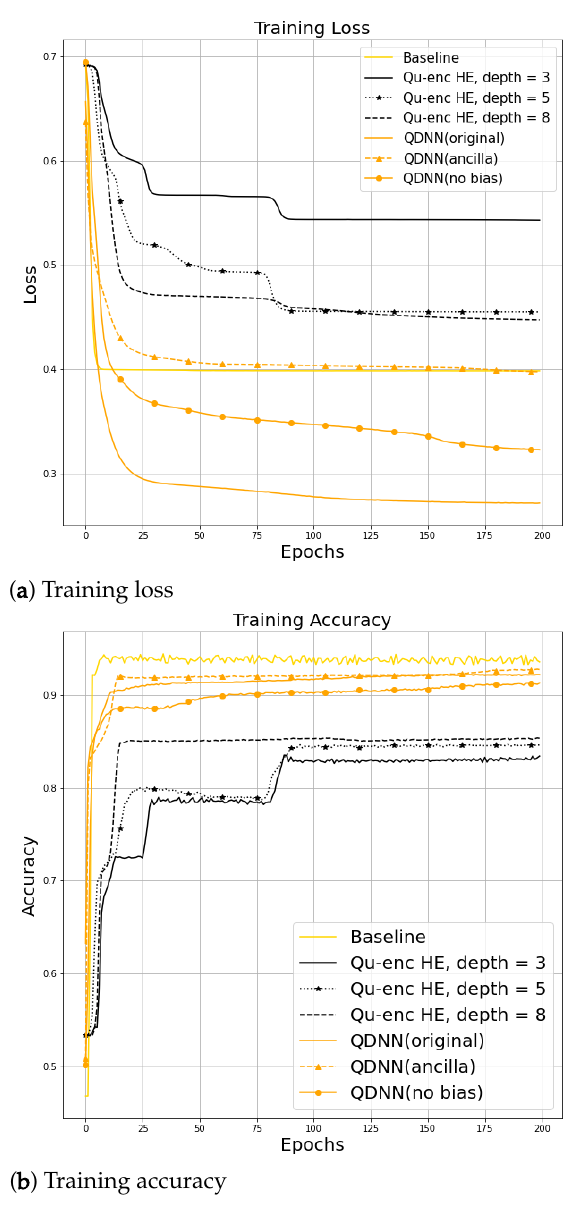
Figure 9. Learning curves in training of different QNNs